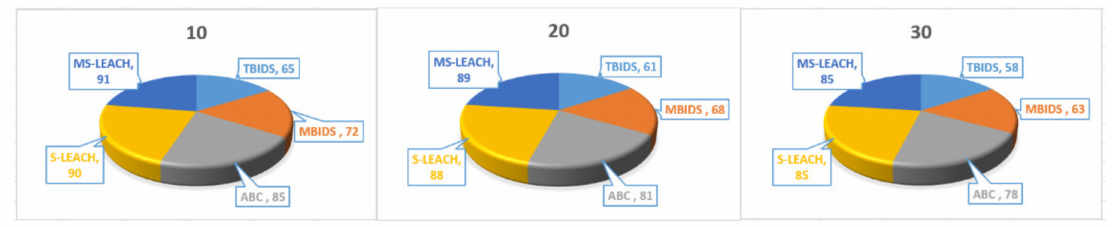
Figure 14. Energy consumption for a large-scale network, 8000 nodes, with 10, 20, 30 sink nodes, and 5